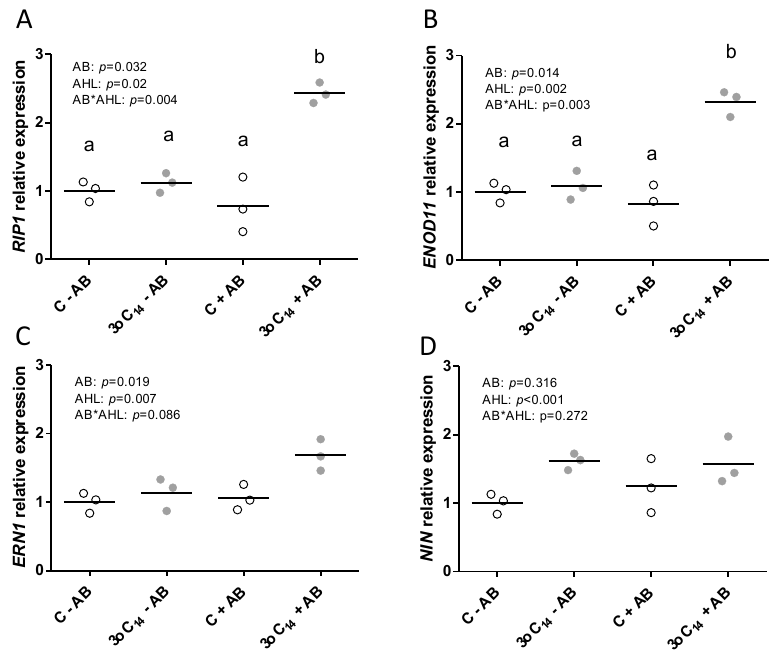
Figure 6. Effect of AHLs on the relative quantification of gene expression of four-day-old M. truncatula roots 24 h after rhizobia inoculation treated with 1 µ M 3-oxo-C 14 -HL (‘3oC14’; grey) or solvent control (‘C’, white). ( A ) RIP1 , ( B ) ENOD11 , ( C ) ERN1 , ( D ) NIN1. All expression ratios are relative to the control (‘C’)-treated samples (no AHL, no AB) and normalized against GAPDH expression. REML test p < 0.05 with Bonferroni’s post-test. No post hoc test when the interaction is not significant. Each sample contained five roots per biological replicate.